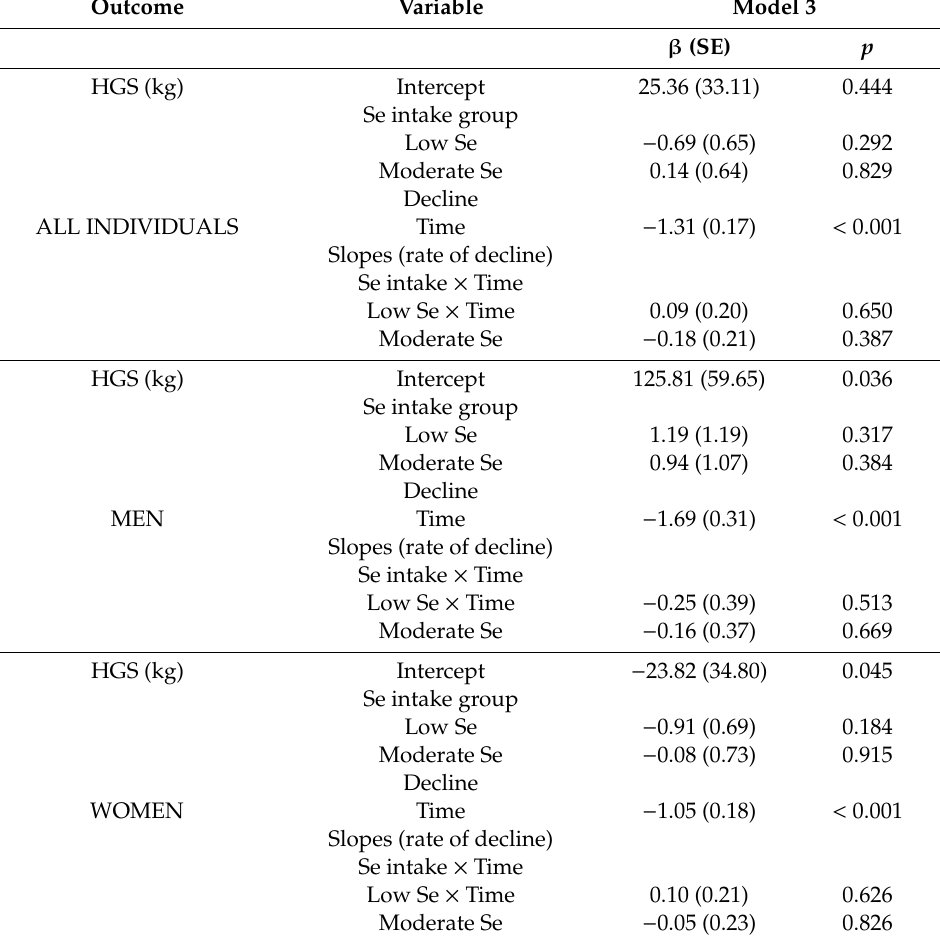
Table 4. Hand grip strength (kg) and timed-up-and-go (log 10 -s) trajectory estimates in low, moderate and optimal selenium over 5 years separated by